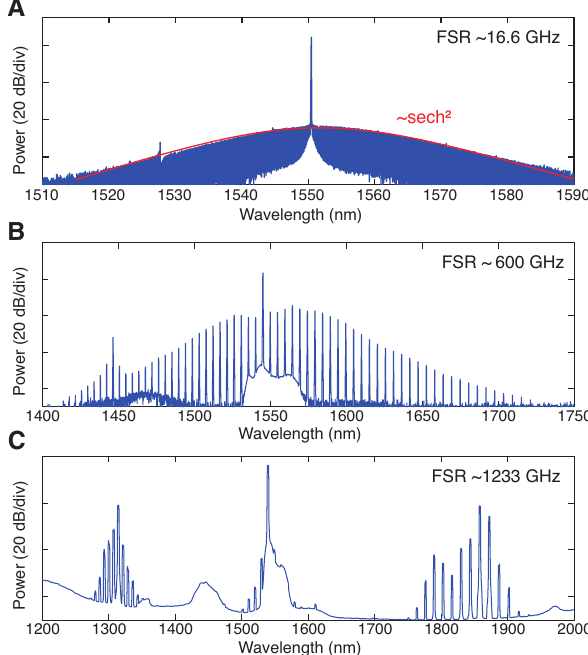
Figure 13: Experimentally observed optical spectra of Kerr frequency comb. (A) Soliton comb formation in a MgF crystalline microresonator 2 with an FSR of 16.6 GHz. The solid red line ( ~ sech 2 ) shows a single soliton state with smooth spectrum envelope. (B) Optical spectrum with dispersive wave emission around 1450 nm in a silica toroid microresonator. (C) Clustered comb formation in a normal dispersion operated silica toroid